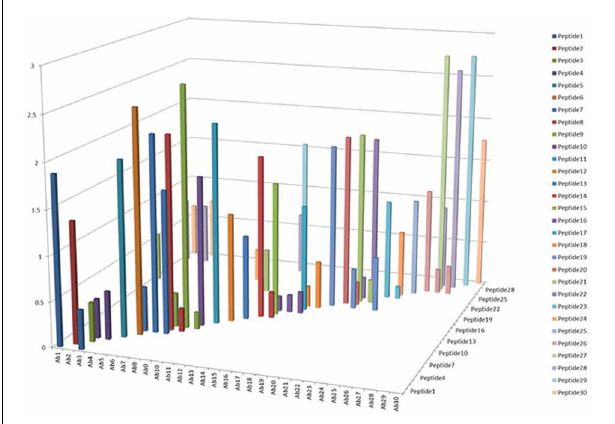
FIGURE 1 | Specificity testing of the array antibodies. 30 antibodies generated against 30 different peptides derived from monoclonal antibody on the market were tested for their specificity in Direct ELISA. Each peptide was coated onto a 96-well plate, after blocking with 1% BSA in PBS-T (phosphate-bufferedsaline with 0.1% Tween-20), all the 30 different antibodies were tested against each peptide, and a total of 900 combinations will be produced. The peptide-antibodycomplex was further recognized by goat anti-rabbit IgG-HRP conjugate, and TMB was used as HRP substrate for color development, triplicate assays were used for the